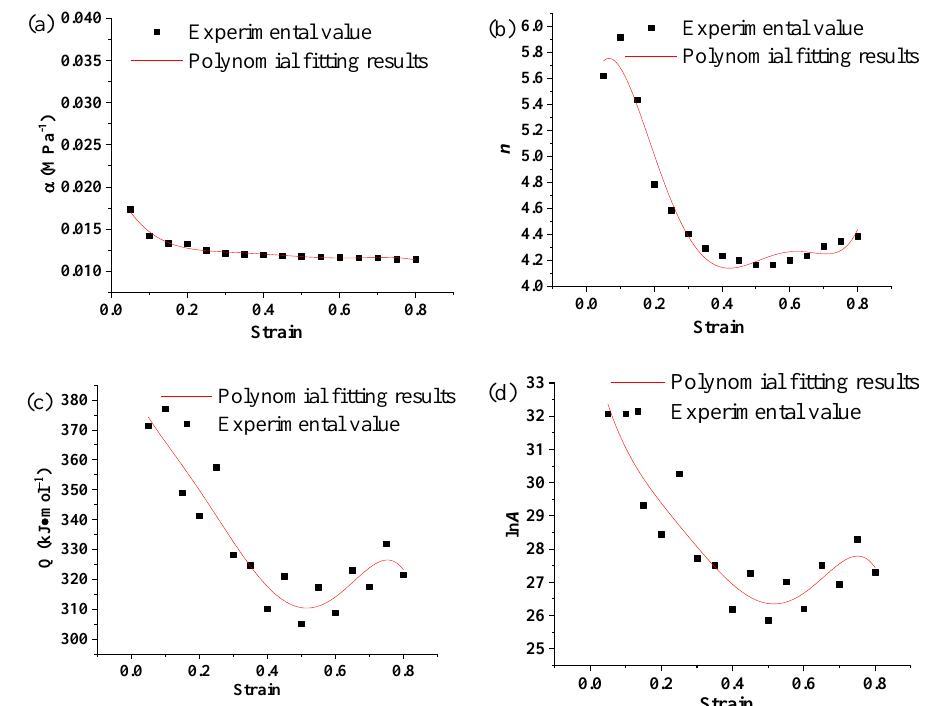
Figure 6. Fifth-degree polynomial fitting of material constants ln A , α , Q , and n with strain: ( a ) α , ( b ) n , ( c ) Q , and ( d ) ln A